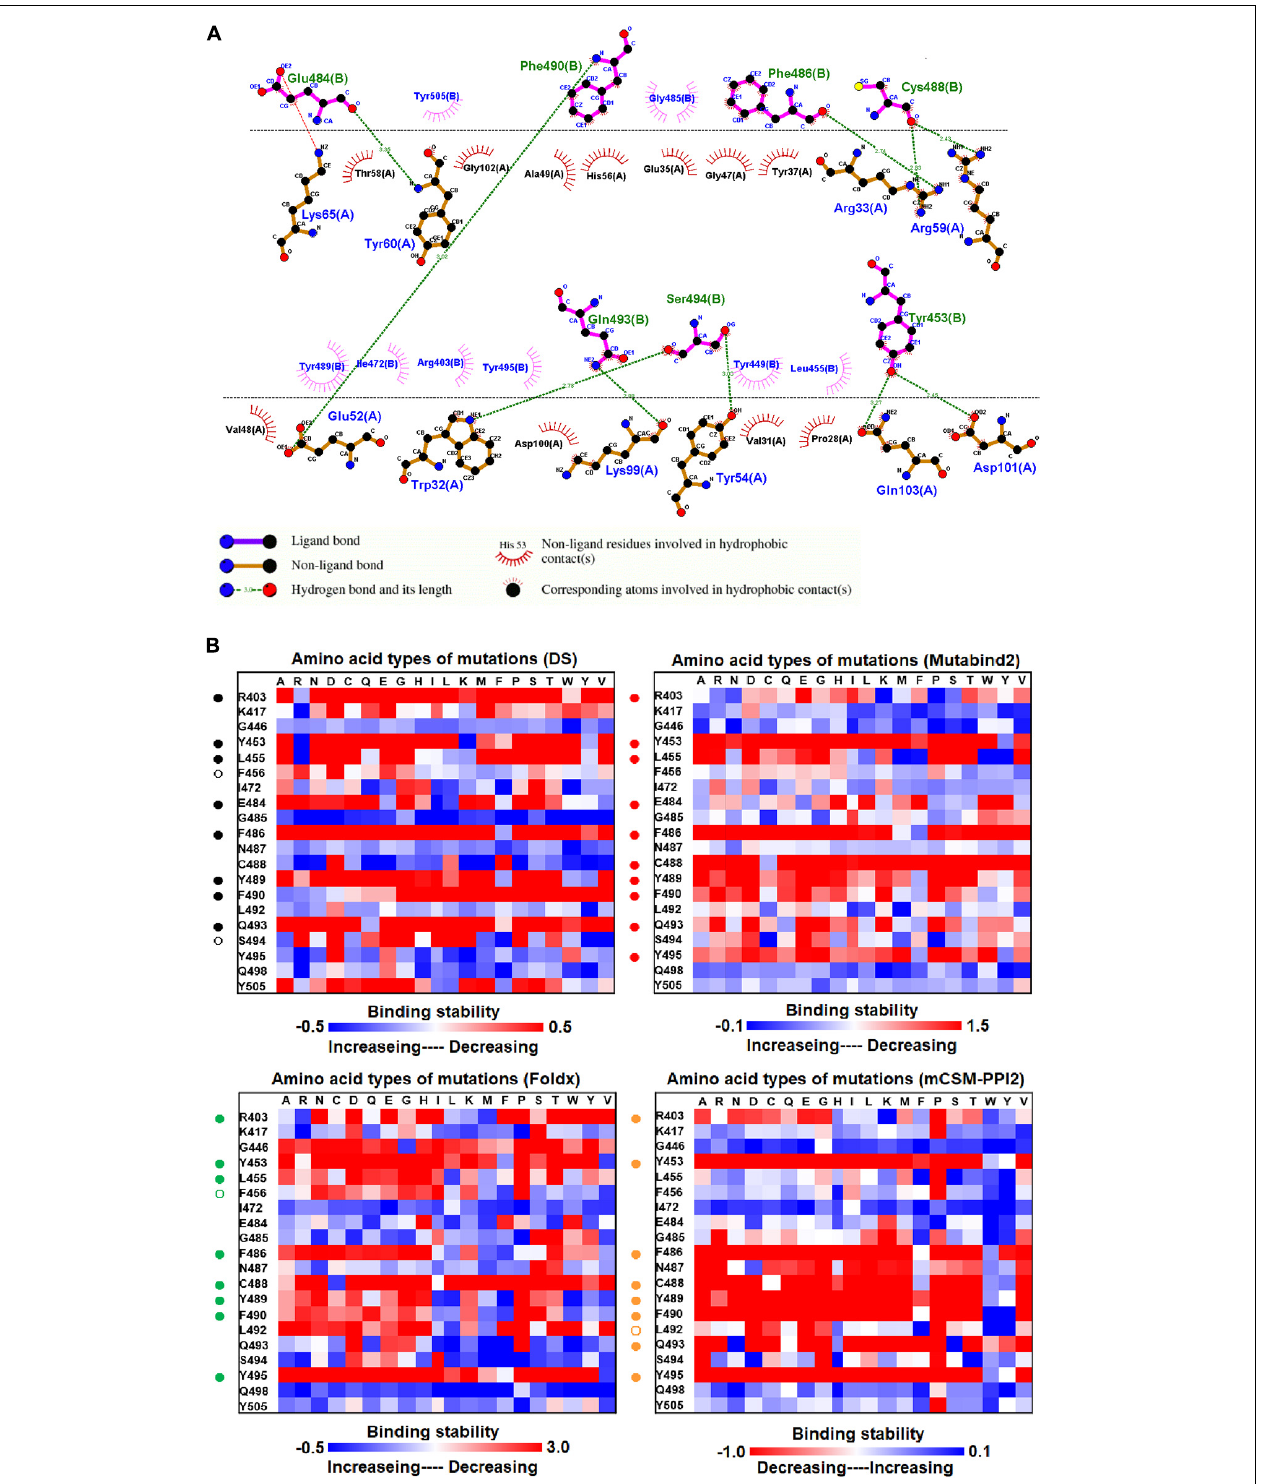
FIGURE 5 | The mutational binding stabilities of RBD variants interacting to MR17 sybody. (A) The molecular interactions of SARS-CoV-2 RBD with MR17 sybody analyzed by ligplot. The chains A and B correspond to MR17 sybody and RBD, respectively. (B) The heatmap of interactive residues of RBD derived from the calculated mutational binding stabilities by using Discovery Studio 3.5 (DS), Mutabind2, FoldX, and mCSM-PPI2. The boxes of each mutations were colored with the gradient of a range between blue (stabilized binding) and red (destabilized binding). In all panels, the solid and hollow circles represent significant and moderate decreases of the binding stabilities,